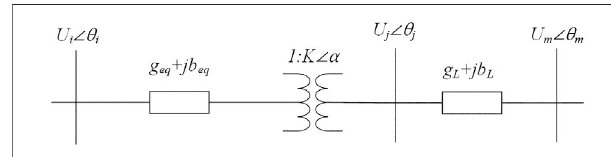
FIGURE 2 | The equivalent circuit of the branch with phase-shifting